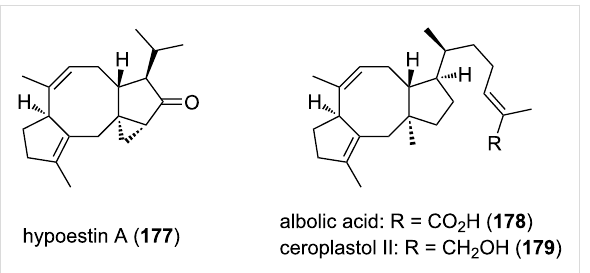
Figure 5: Structural representations of hypoestin A ( 177 ), albolic acid ( 178 ), and ceroplastol II ( 179 ) bearing the same [5-8-5] core structure.